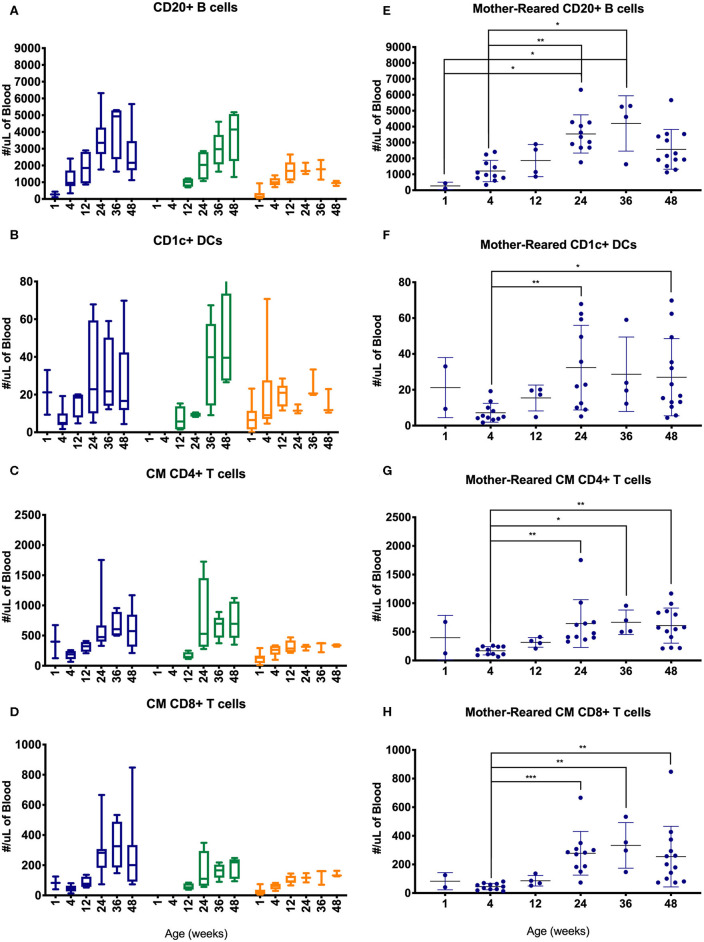
Comparison of selected PBMC immunophenotyping parameters. Age binning was completed for samples from animals with average ages of 1 week (0–2 weeks old), 4 weeks (3–5 weeks old), 12 weeks (11–13 weeks old), 24 weeks (22–26 weeks old), 36 weeks (34–38 weeks old), and 48 weeks (46–50 weeks old) of the Colony MR cohort (blue), Colony NR (green), and Research NR cohort (orange). Results are shown for; (A,E) CD20+ B cells, (B,F) CD1c+ dendritic cells, (C,G) CM CD4+ T cells, and (D,H) CM CD8+ T cells. Panels (A–D) were plotted using box and whiskers depicting median, minimum and maximum values and panels (E–H) applied statistical analyses of results (mean ± st. dev.) from the Colony MR animals using Kruskal-Wallis test coupled with Dunn's multiple comparisons to illustrate how CBC parameters vary with age. *P < 0.05; **P < 0.01; ***P < 0.001.